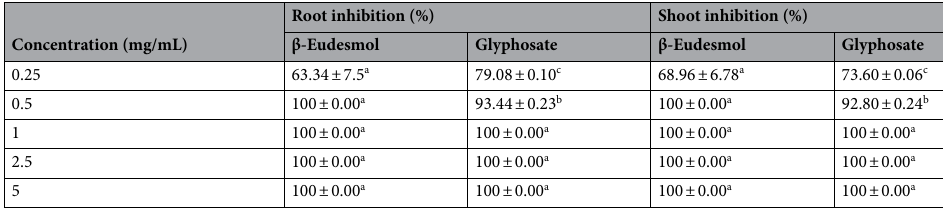
Table 7. Phytotoxic effect of β-eudesmol and glyphosate on seedling growth of P. annua . a ± Standard error ( n = 30). b Different letters represent a significant difference at p < 0.05 level according to Fisher’s LSD